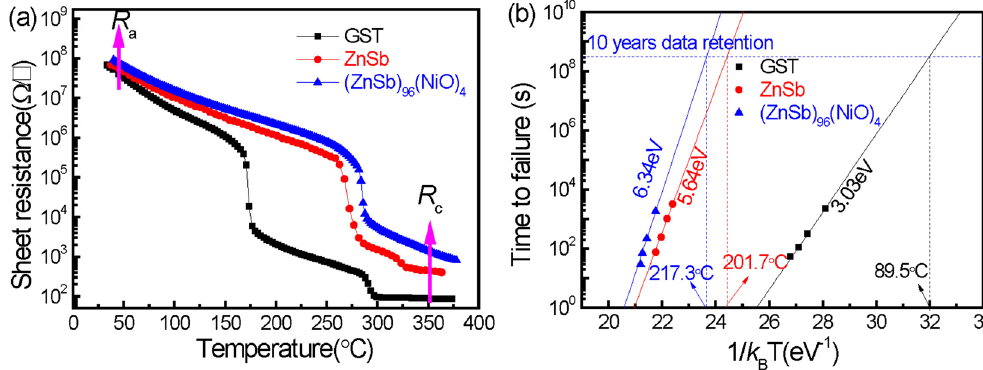
Figure 2. ( a ) Sheet resistance as a function of temperature for GST, undoped and NiO-doped ZnSb films. ( b ) The Arrhenius extrapolation at 10-year of data retention for GST, undoped and NiO-doped ZnSb